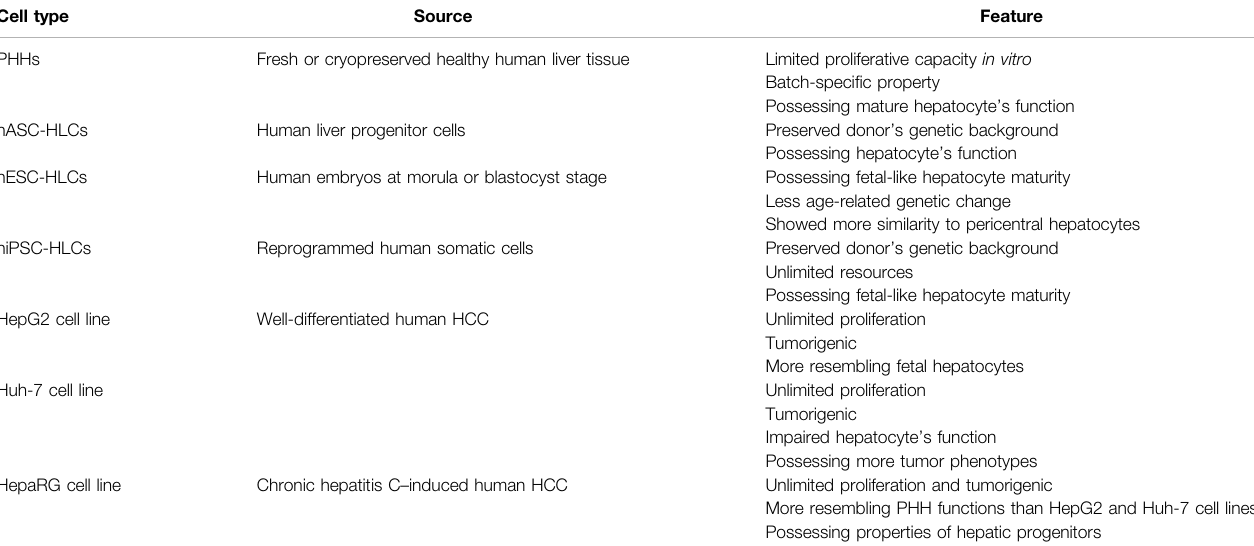
TABLE 1 | Summary of characteristics of cell types used in human 3D hepatic